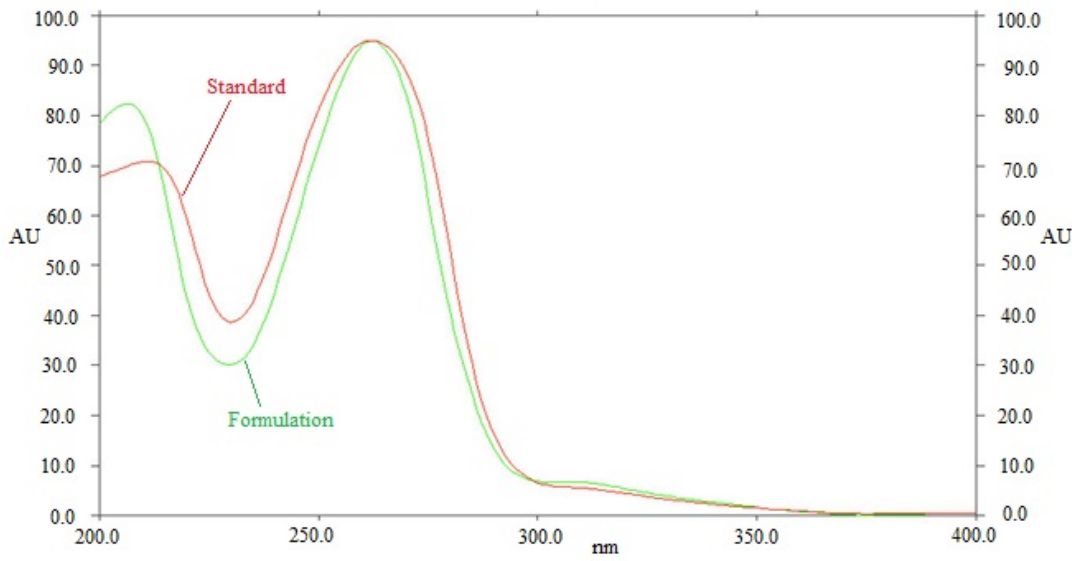
Figure 4. UV-absorption spectra of standard CDN and formulation,